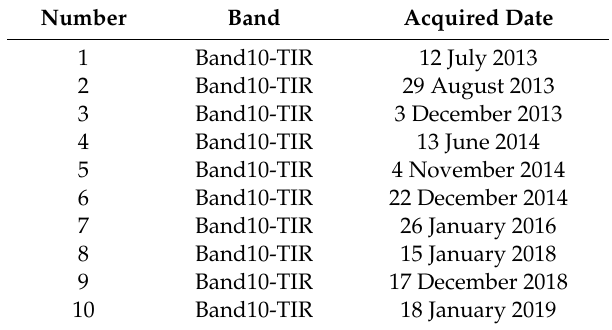
Table 2. Remote-sensing data.